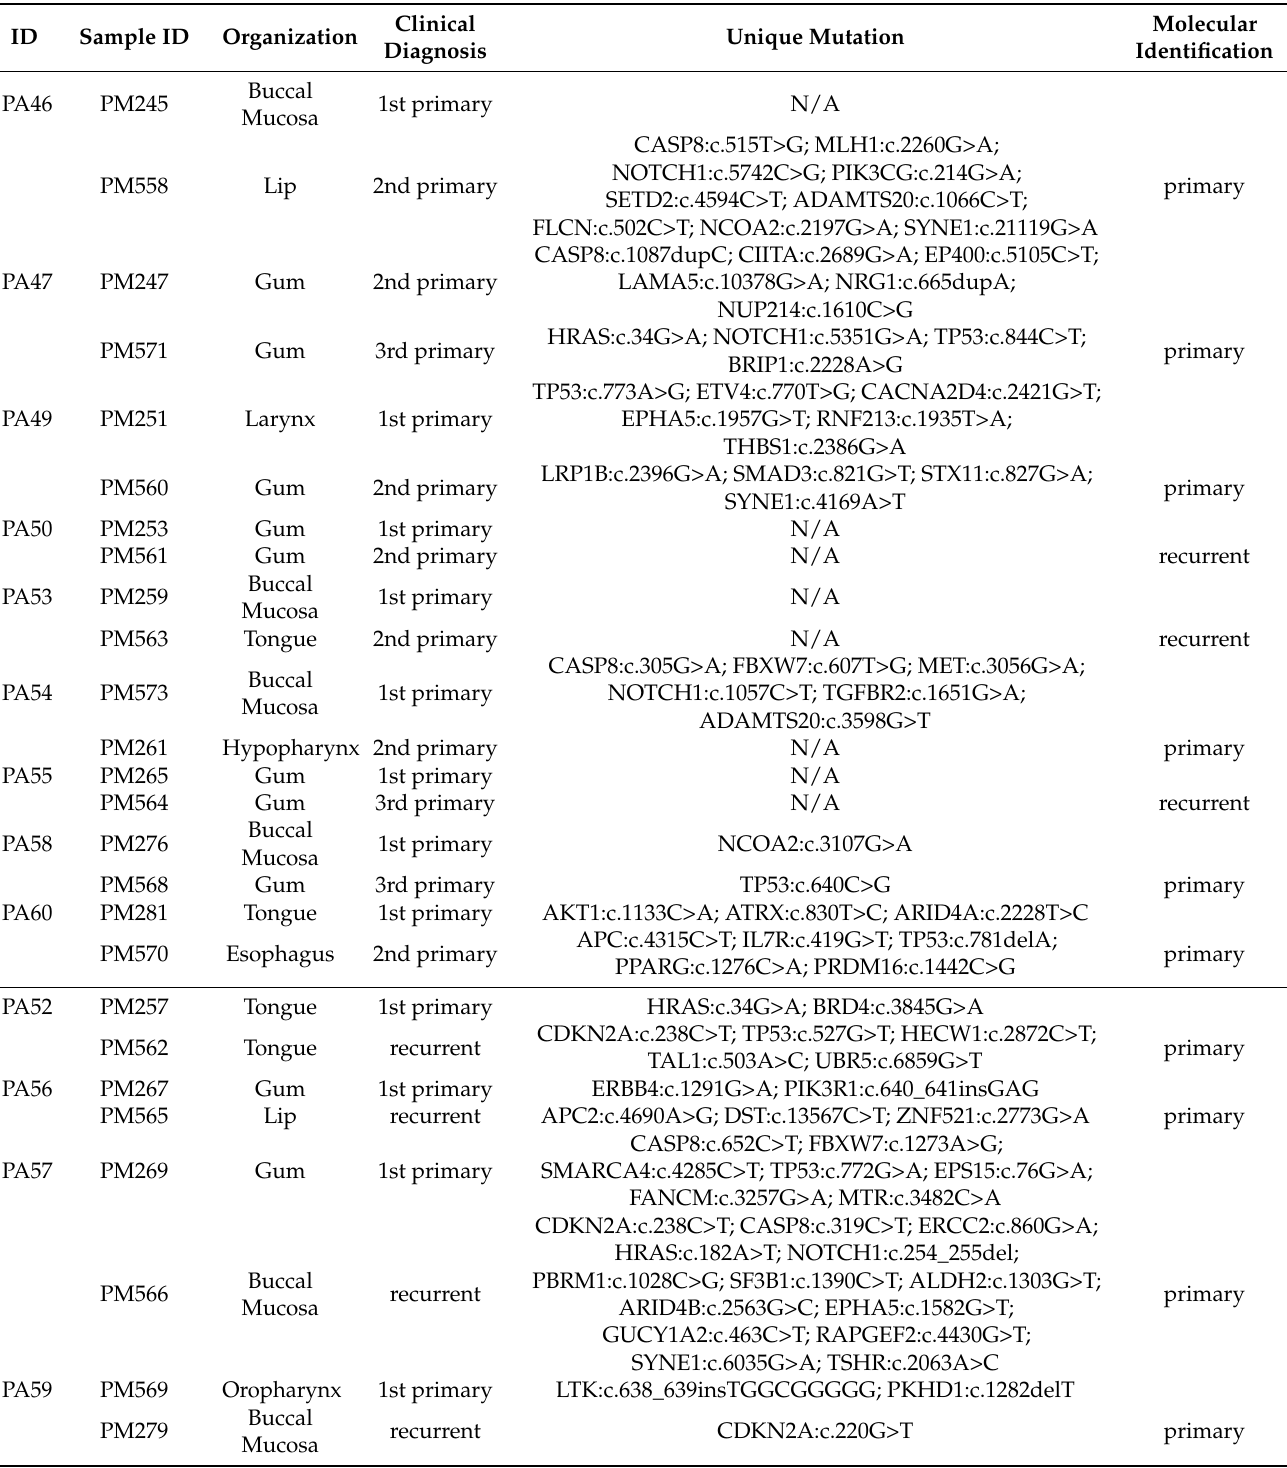
Table 2. Unique mutations in first and second primary